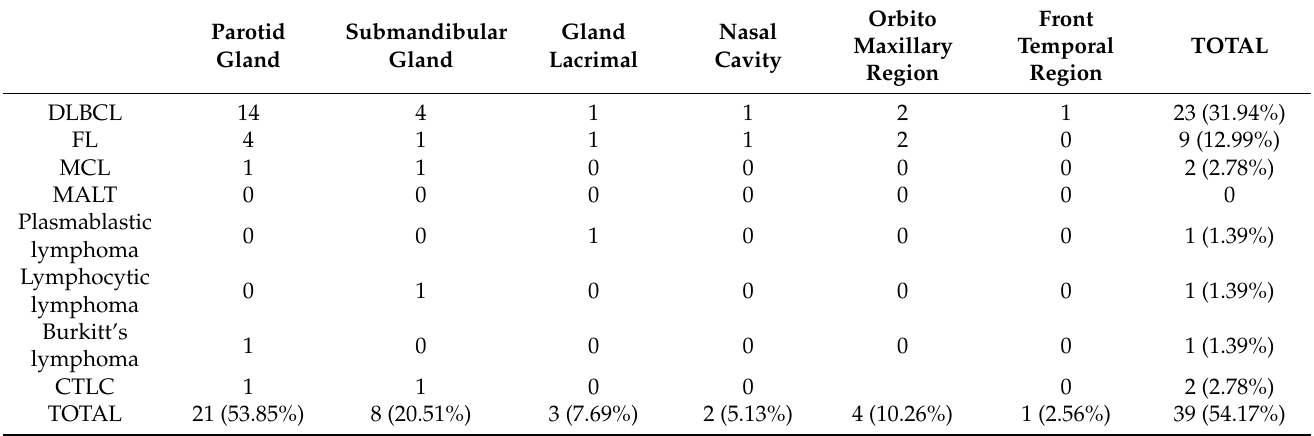
Table 3. Histology and localization of non-oral